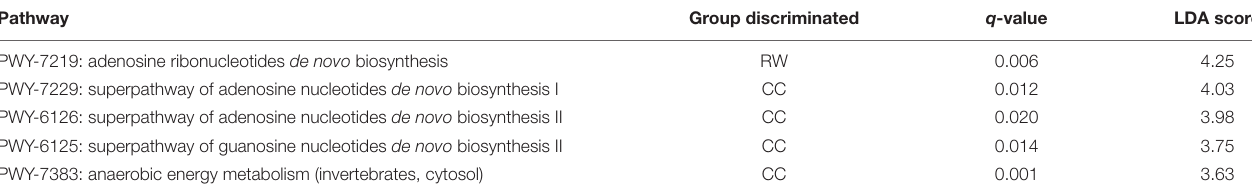
TABLE 2 | Discriminative pathways for RW and CC groups as identified by LEfSe analysis. Pathway Group